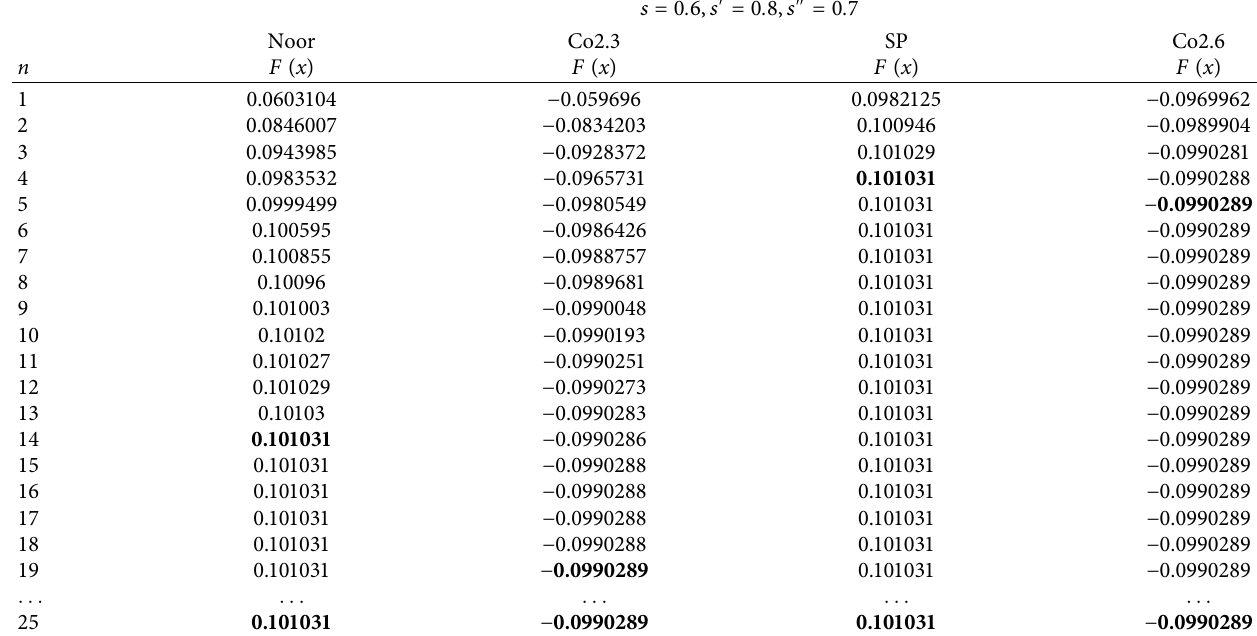
Table 4: Iterations of cubic function s � 0 . 6 ,s ′ � 0 . 8 , s ″ � 0 . 7.